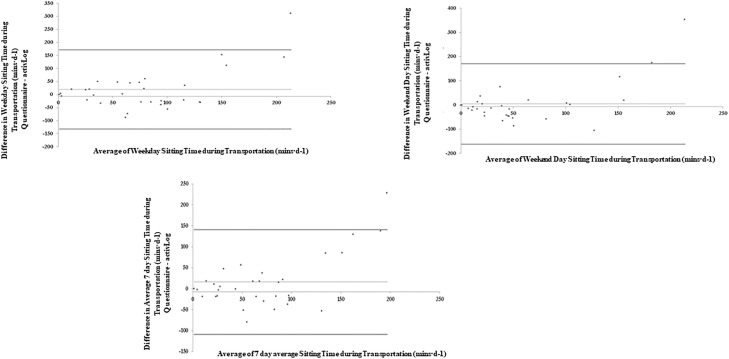
Bland-Altman plots of absolute agreement of sitting time during transportation time (weekdays, weekend days and average of last 7 days) derived from the questionnaire with the equivalent variable derived from the criterion measure (combination of AP3M determined sedentary time and the domain specific log).